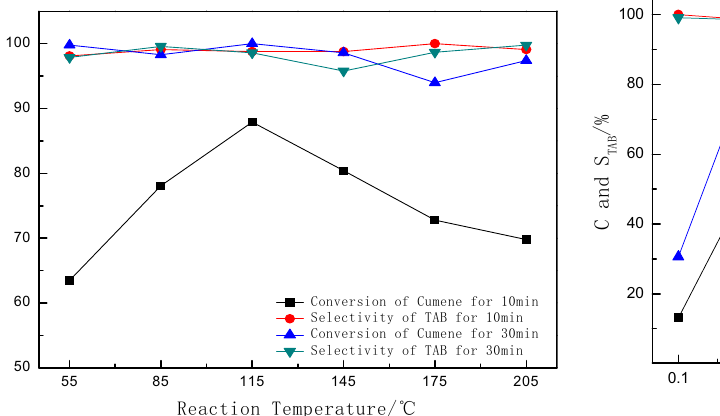
Figure 5: The e ff ect of reaction temperature on the conversion of cumene and selectivity toward TAB.